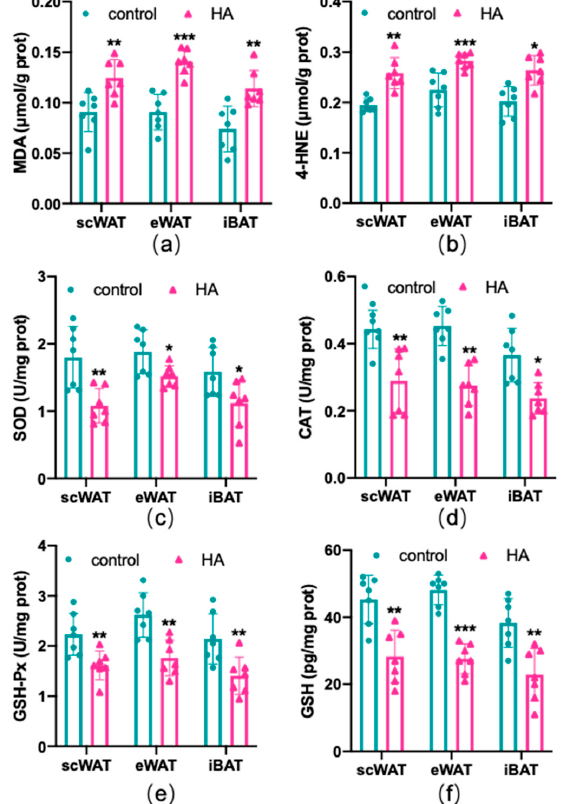
Figure 4. Oxidative stress-related factors in both WAT and BAT from HA exposure for 4 weeks. Graphs ( a , b ) display the levels of MDA and 4-HNE (ELISA). Graphs ( c – e ) display the enzyme activity of SOD, CAT, and GSH-Px (enzyme activity detection). Graph ( f ) displays changes in the expression of GSH (ELISA). Data are expressed as the mean ± SEM; n = 7. * p < 0.05, ** p < 0.01, and *** p < 0.001, compared with the control group.